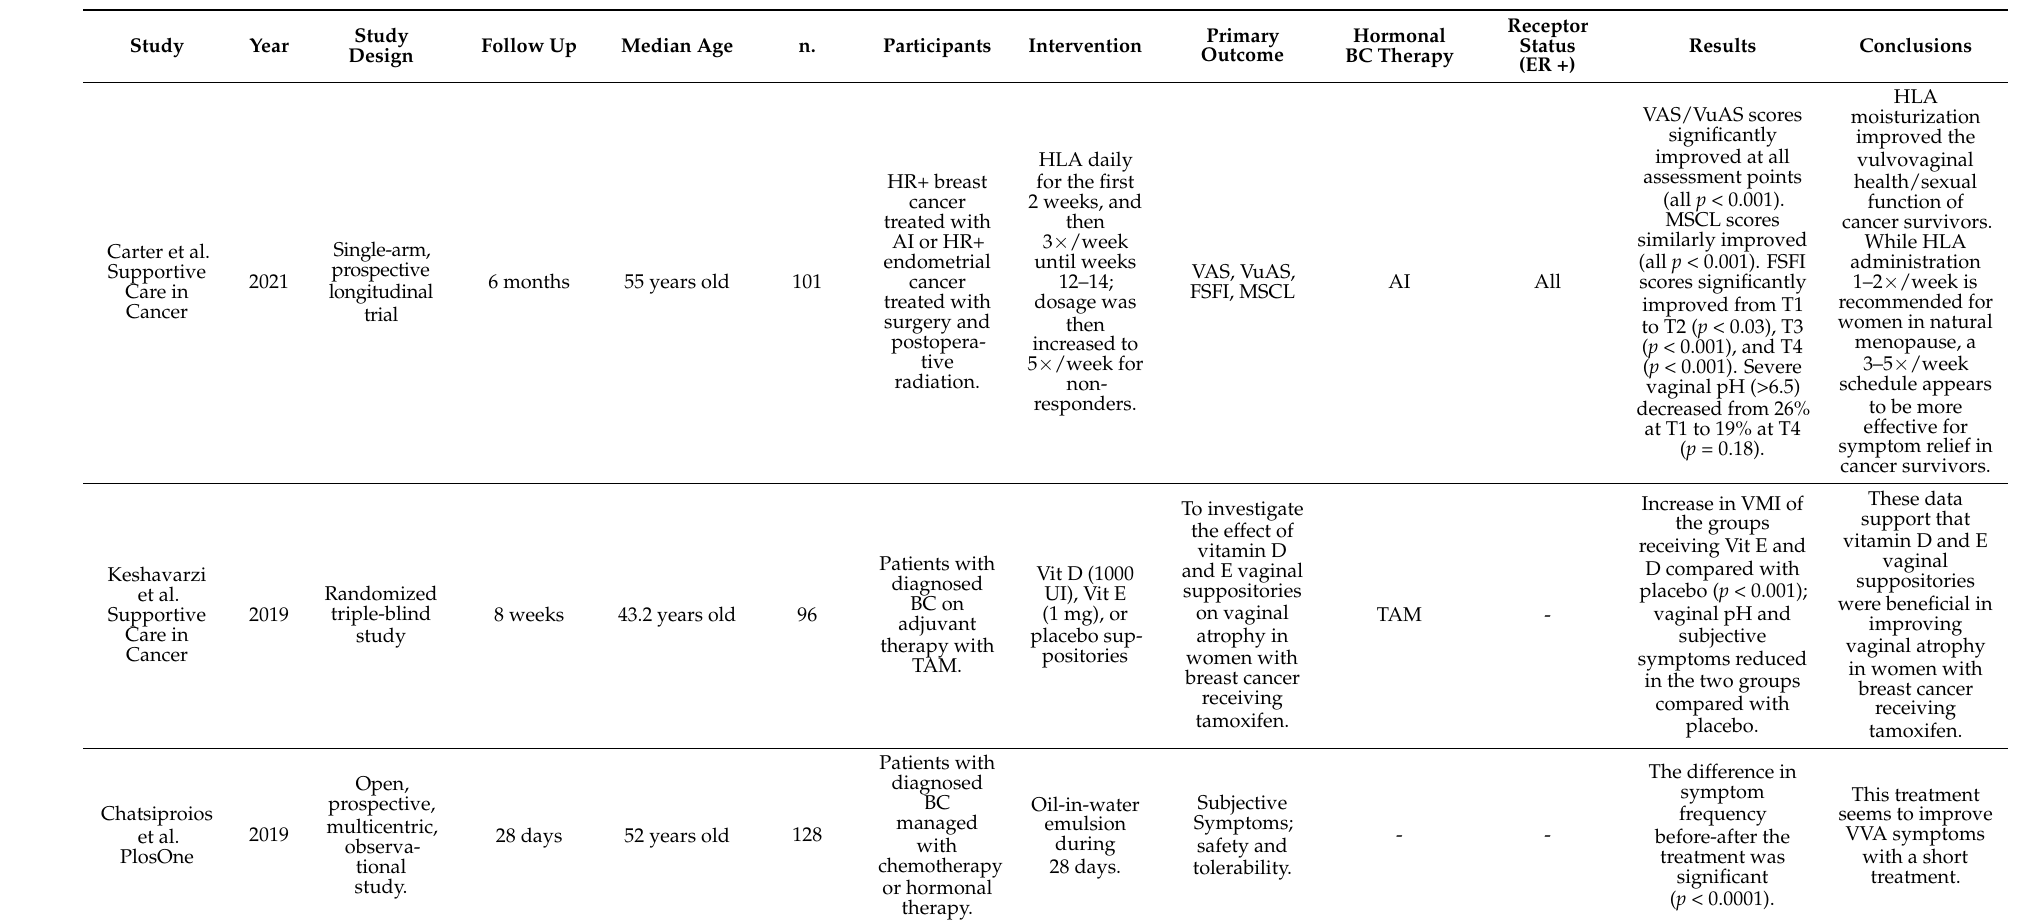
Table 1. Non-hormonal